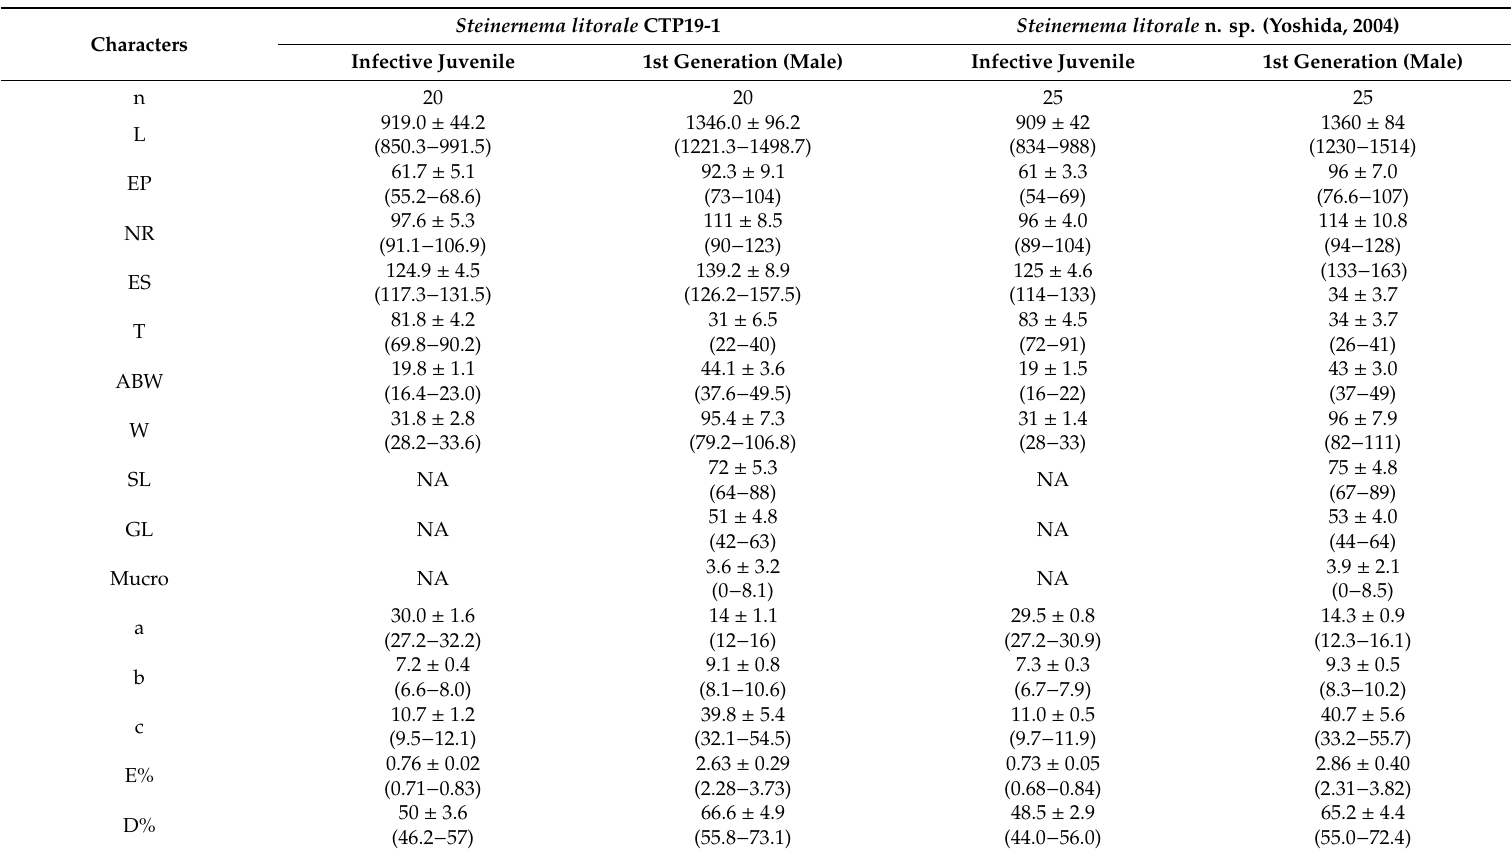
Table 2. Morphometrics of Steinernema litorale CTP19-1. All measurements are in micrometers (except n, ratio, and percentage). Data are expressed as mean ± SD